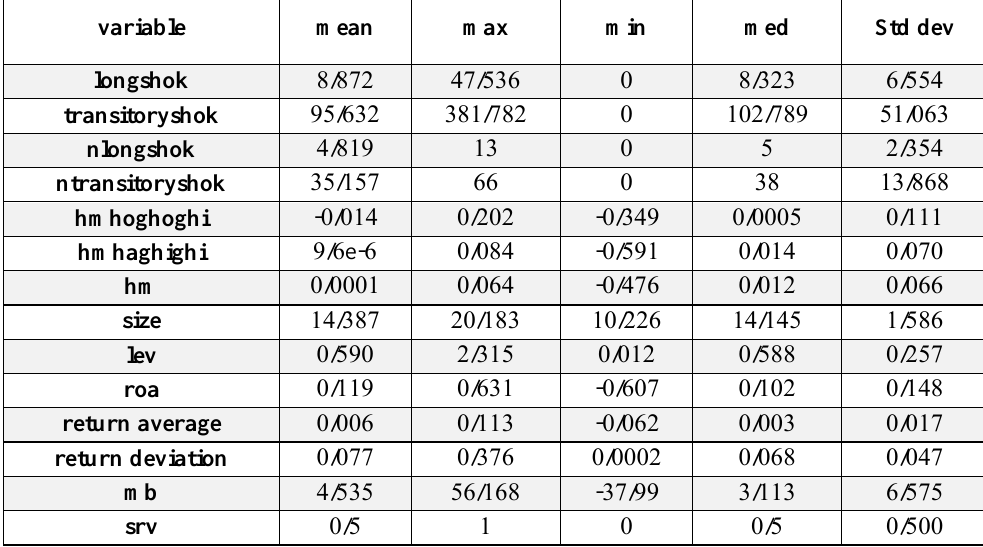
Table 1. Descriptive statistics for study